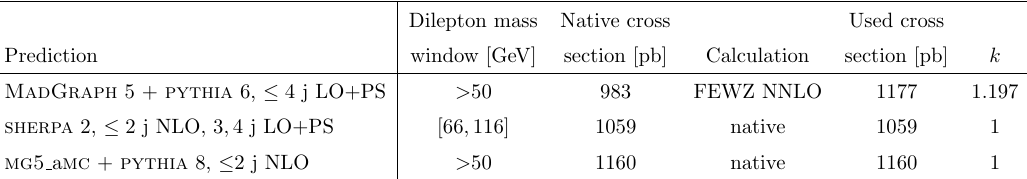
Table 2 . Values of the pp ! ‘ + ‘ (cid:0) total inclusive cross section used in the predictions in data-theory comparison plots. The cross section used for the plots together with the one obtained from the generated sample (\native") and their ratio ( k ) are provided. The cross section values correspond to the dilepton mass windows used for the respective samples and indicated in the